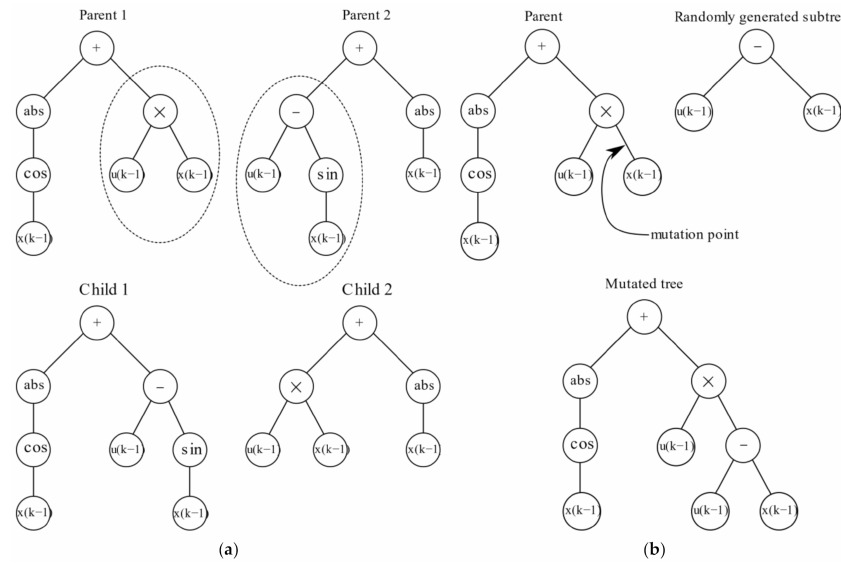
Figure 1. Genetic operators: ( a ) crossover ( b ) mutation.